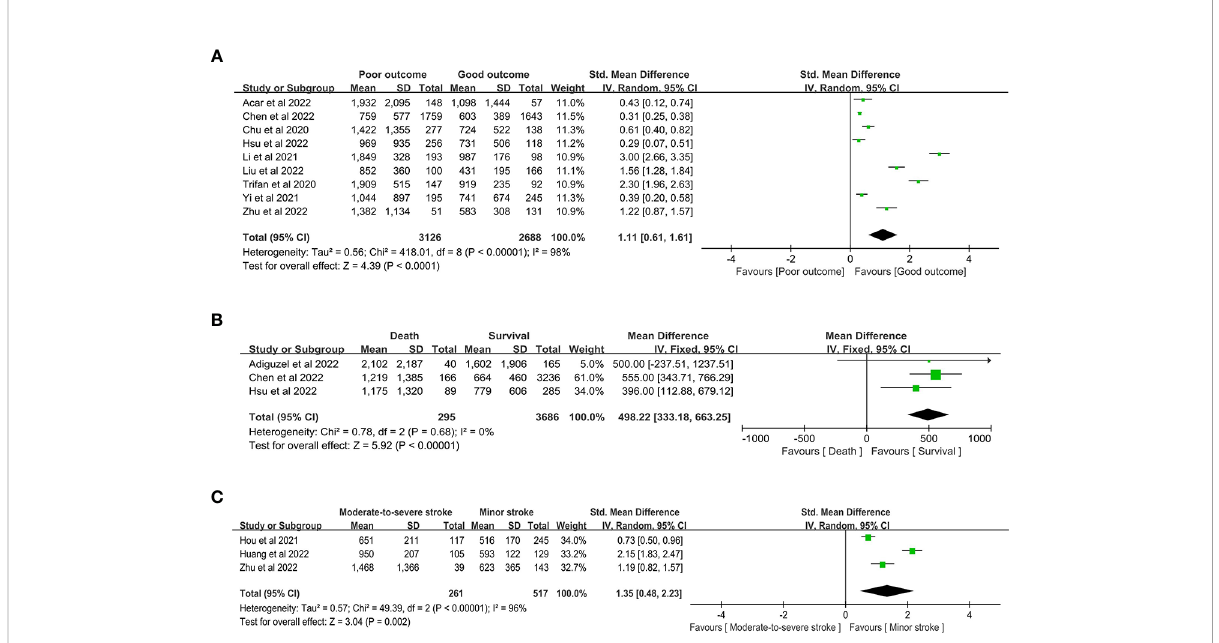
FIGURE 7 theSIIlevelbetweenthe (A) pooroutcomeandgoodoutcomegroup, (B) deathandsurvivalgroup,and (C)